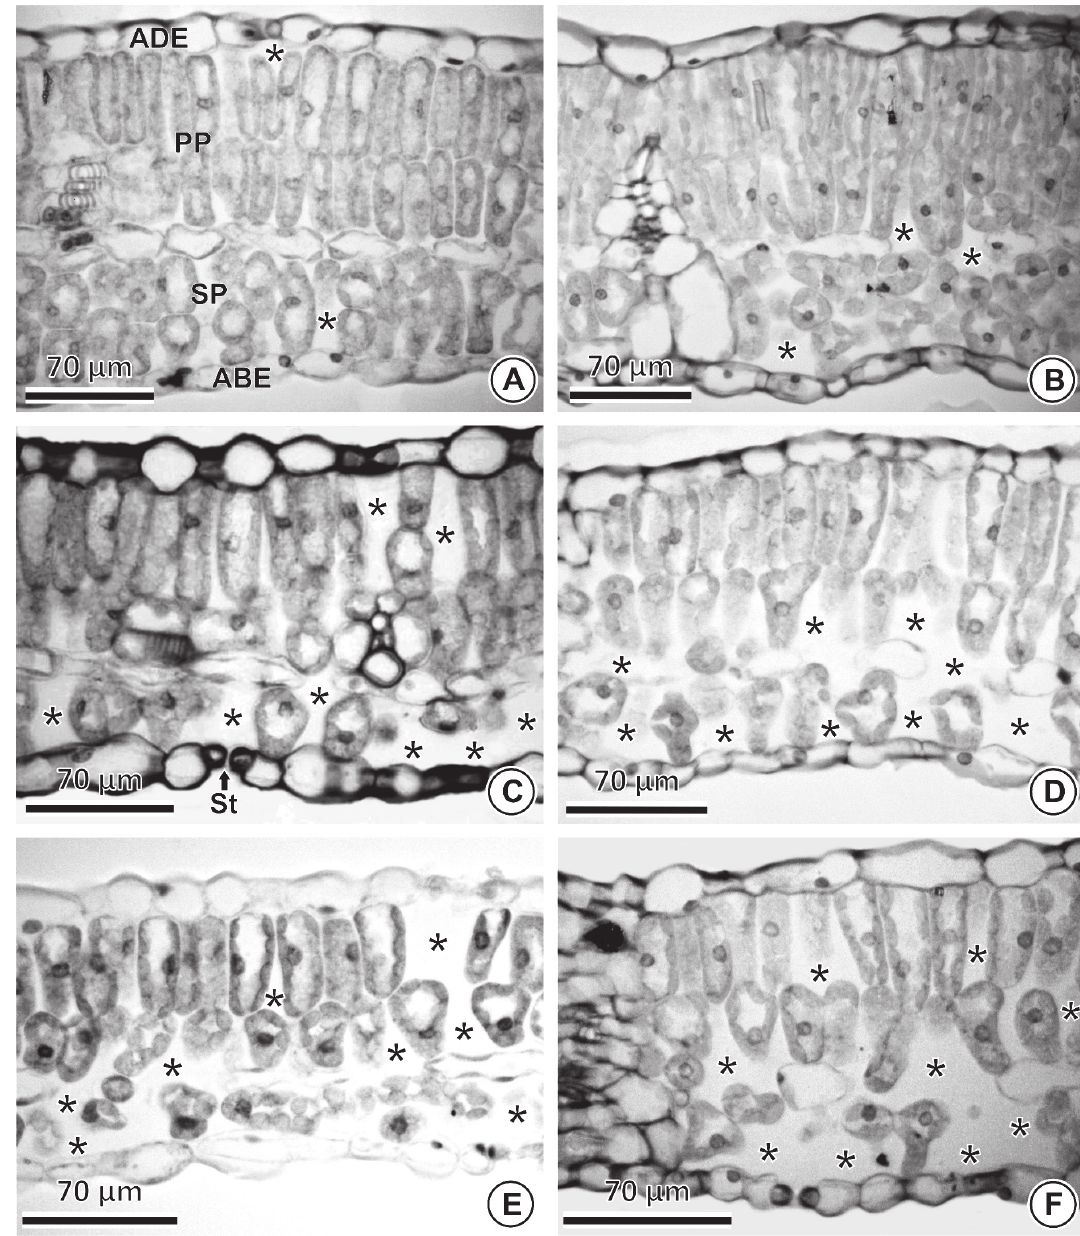
Fig 2 - Leaf structure of Neonotonia wightii (A, C, and E) and Pueraria phaseoloides (B, D, and F) cultivated under different light intensities (transverse sections observed by light microscopy). (A and B) : full sunlight; (C and D) : 30% shade; and (E and F) : 50% shade. Abbreviations: ADE, adaxial epidermis/surface; ABE, abaxial epidermis/surface; PP, palisade parenchyma; SP, spongy parenchyma; St, stomata; and *, intercellular